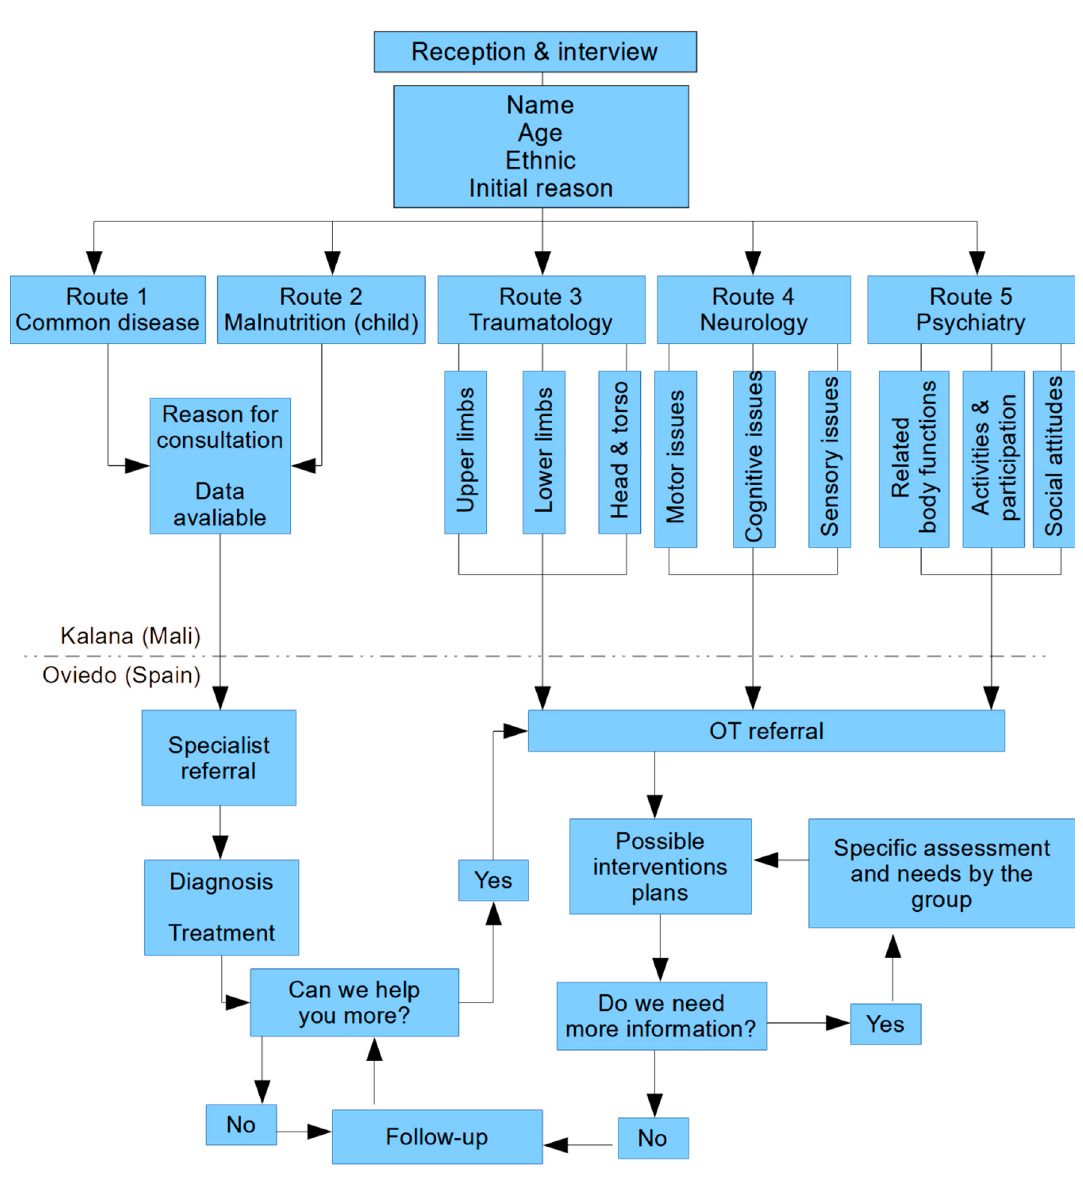
Figure 3. Data analysis protocol.